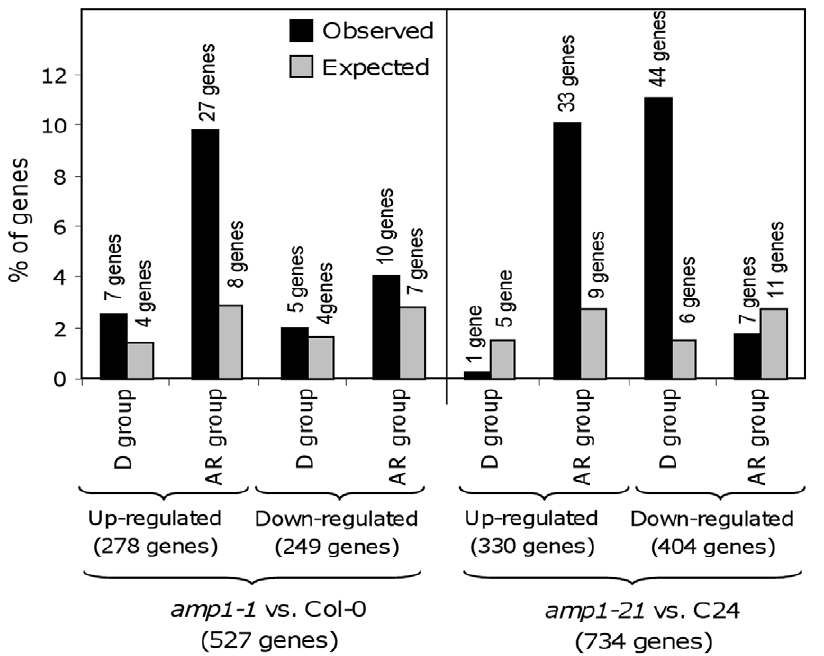
Figure 6. Analysis of the genes de-regulated in amp1-1 and amp1-21 . The percentage of genes observed and expected (considering random distribution) for each category is shown. The number of genes observed and expected is also indicated above each column. D (Dormant) and AR (After-Ripened) groups were defined in Cadman et al. (2006), containing 442 and 779 genes, respectively.